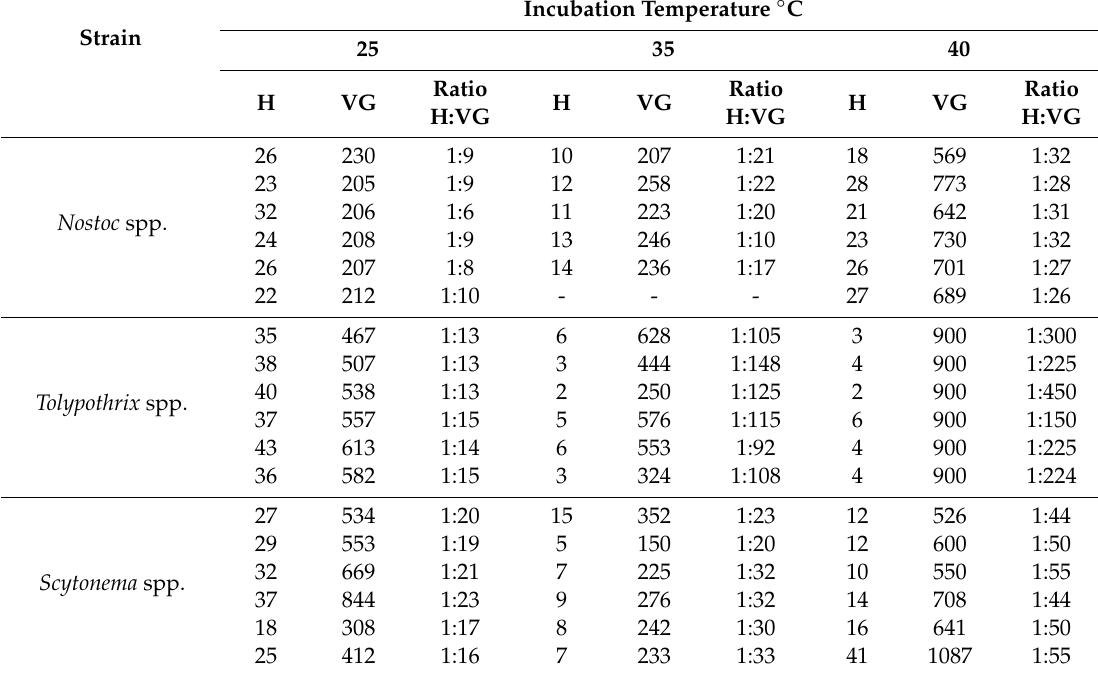
Table 1. Frequency of heterocysts (number of vegetative cells per heterocyst) in representative cyanobacterial strains after incubation at 30, 35 and 40 ◦ C for 7 days. Averages of n = 6 determinations ± standard deviation are given. H: heterocystous, VG: Vegetative cells.